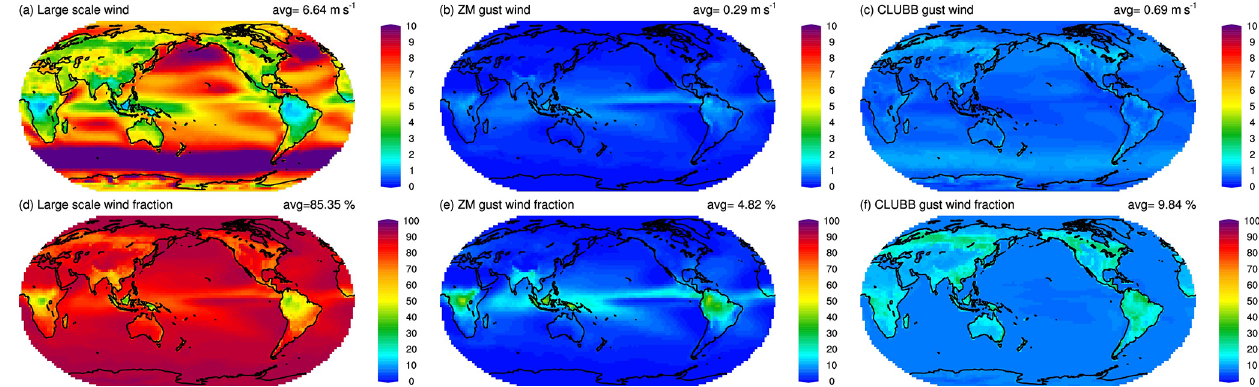
Figure 1. Present-day EAMv1 climatology of wind speed (ms − 1 ) at the lowest model level in (a) resolved motion, (b) gustiness associated with the ZM parameterization, and (c) gustiness associated with the CLUBB parameterization. Panels (d) – (f) are the fractional contribution of the three components to the total wind